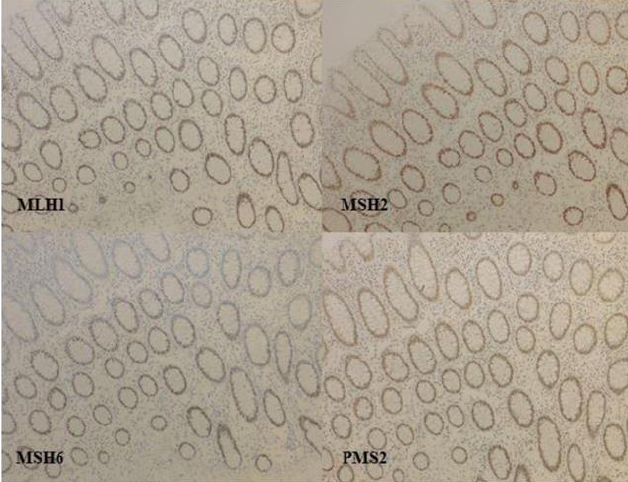
Figure 1. Immunochemistry of MMR proteins in colorectal cancer: a proficient MMR tumor, normal colonic mucosa, no loss of expression of MMR proteins. Antibodies used: anti-MLH1 (clone M1 Ventana ® Oro Valley, AZ, USA, kit Optiview ® for revelation, Roche Diagnostics, Meylan, France); anti-MSH2 (clone G219-1129 Ventana ® , kit Optiview ® for revelation); anti-MSH6 (clone 44BD Bio- sciences ® , dilution 1/500, Franklin Lakes, NJ, USA; kit Ultraview ® for revelation, Berkeley, CA, USA); anti-PMS2 (clone EPR 3947 Ventana ® , ready for use; kit Optiview ® for revelation with ampli- fication).